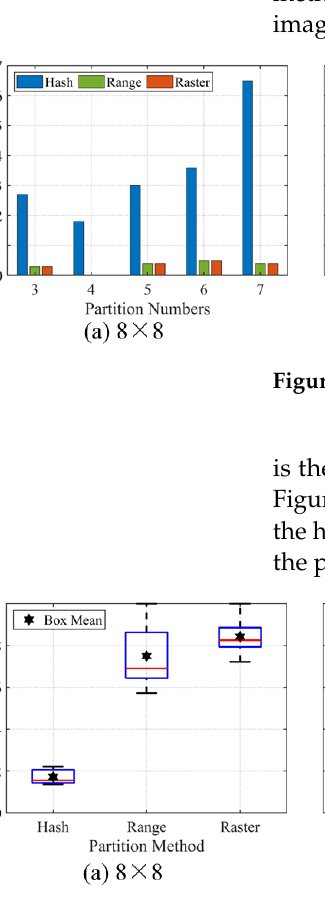
Figure 7. The compactness for various image layout.